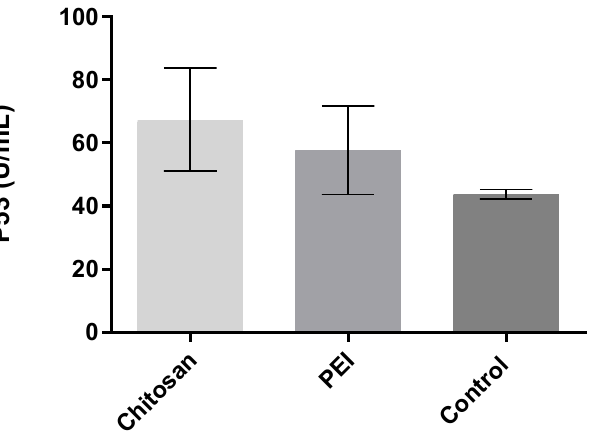
Figure 6. Evaluation of p53 protein expression following administration of p53-pDNA polyplexes of CH and PEI in HeLa cervix carcinoma. Data are represented as mean ± S.D., n = 2.